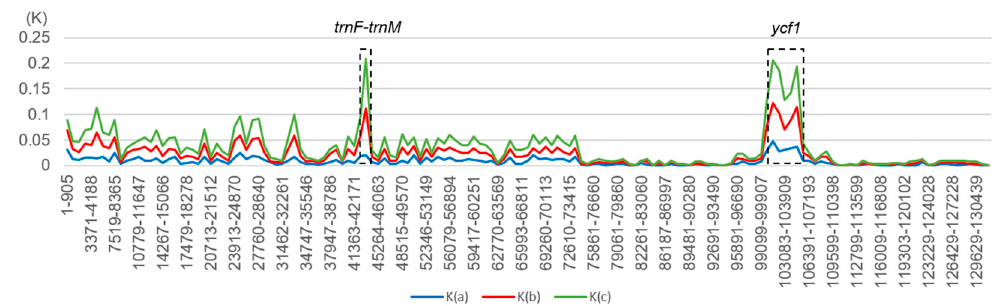
Figure 7. Sliding window analyses of the three whole chloroplast genomes. X-axis: position of a window. Y-axis: sequence divergence between species of each window. K(a): K values between M. bibracteolatus and M. tricolor ; K(b): K values between M. bibracteolatus and M. cochinchinensis ; K(c): K values between M. tricolor and M. cochinchinensis .